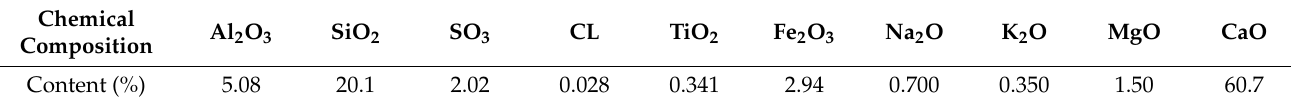
Table 1. Chemical composition of cementitious materials.